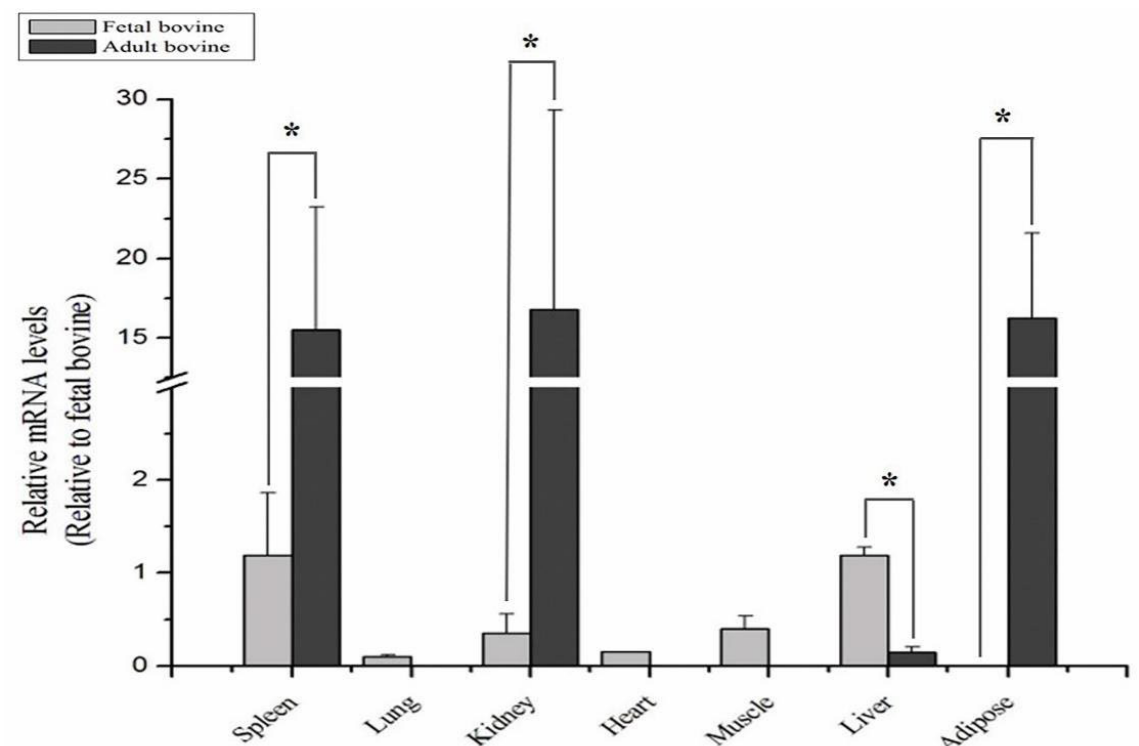
Figure 2. The KAT2B gene mRNA expression profile in Qinchuan cattle. * Indicates a significant difference between two groups ( p < 0.05). Heart in the fetal bovines was the control tissue.